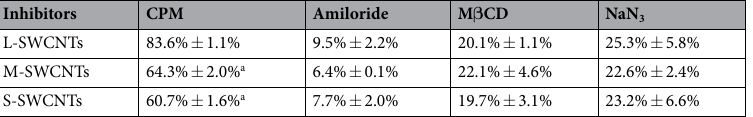
Table 2. The inhibition of SWCNTs endocytosis by specific inhibitors. The percentages were obtained by normalizing the SWCNTs band intensity of the inhibitor treatment groups against the control group (IOD inhibitor /IOD control ). Data are presented as mean ± standard error of mean. a Statistical evaluation by ANOVA: p < 0.05 compared to